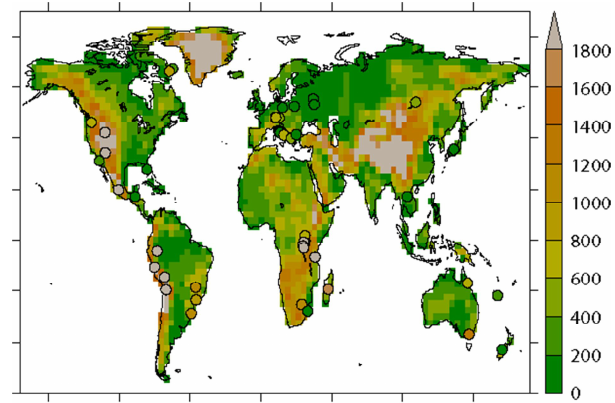
Figure 1. Locations and altitudes of pollen records superimposed on pre-industrial HadCM3 orography